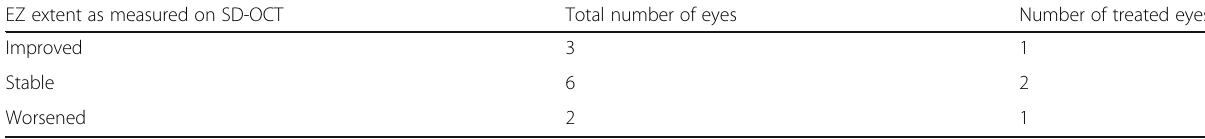
Table 4 Change in SD-OCT measurement by total number of eyes and number of treated eyes EZ extent as measured on SD-OCT Total number of eyes Number of treated eyes Improved 3 1 Stable Worsened